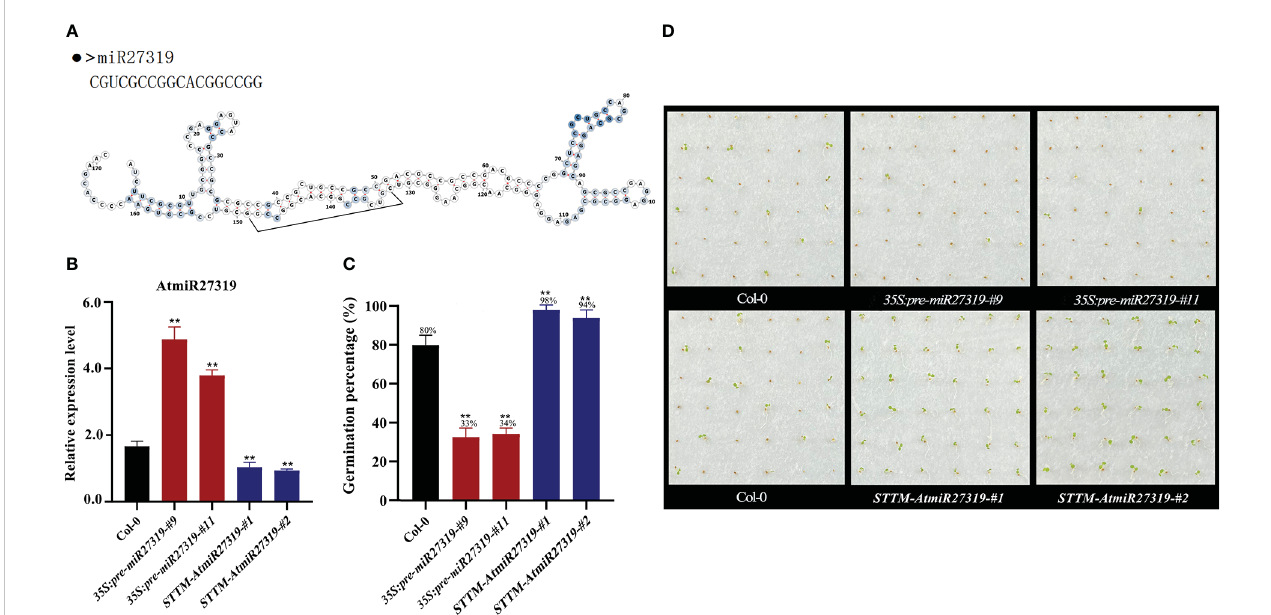
FIGURE 4 Positive roles of miR27319 in regulating seed dormancy in Arabidopsis . (A) The sequence and secondary structure of miR27319. (B) Relative expression of miR27319 in Col-0, 35S:pre-miR27319 , and STTM-AtmiR27319 . Signi fi cant differences were determined using Student ’ s t-test: ** P < 0.01. (C) Seed germination percentages of Col-0, overexpression plants ( 35S:pre-miR27319 ), and STTM plants of miR27319 ( STTM-AtmiR27319 ) in Arabidopsis . (D) The seed images of Col-0, overexpression plants ( 35S:pre-miR27319 ), and STTM plants of miR27319 ( STTM-AtmiR27319 ) in Arabidopsis